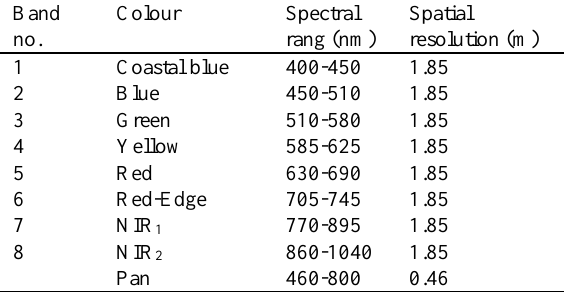
Table 2: Characteristics of the WV-2 imagery.